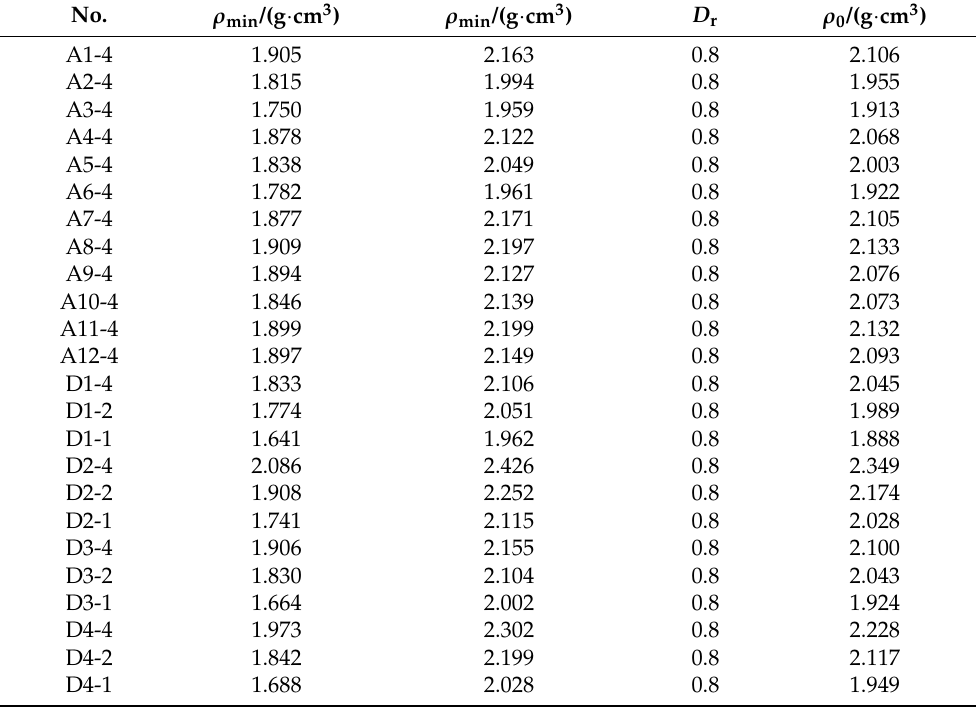
Table 2. Test results of relative compactness of soil samples and dry density of soil